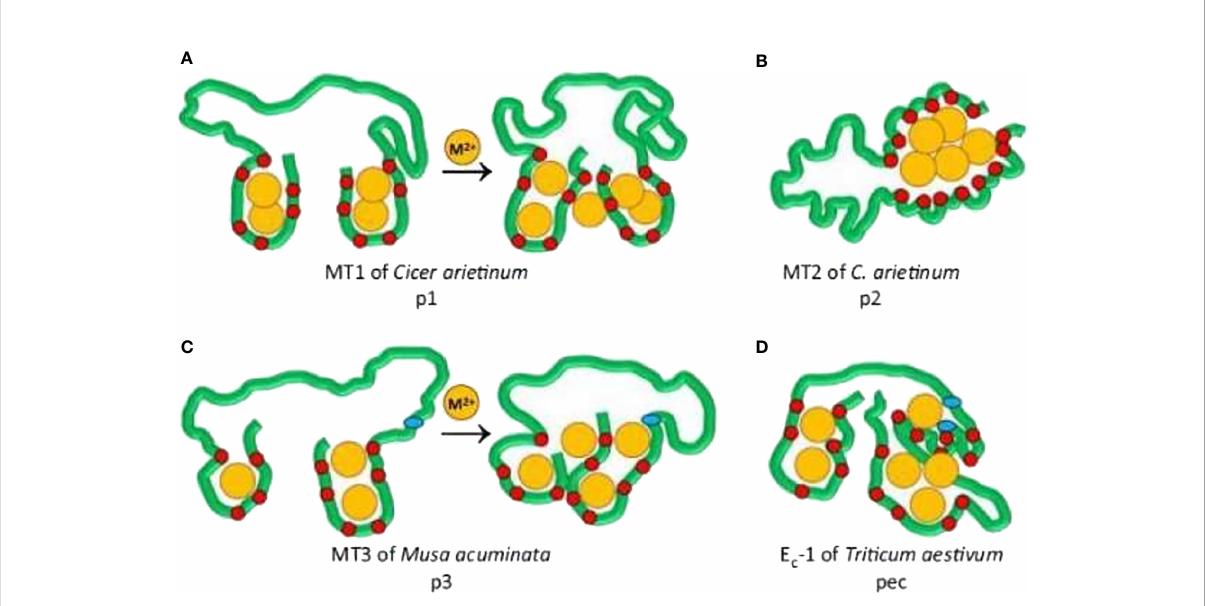
FIGURE 3 Hypothetical model of MTs in plant P1, P2, P3, and pec subfamilies: (A) MT1 in Cicer arietinum, (B) MT2 in C.arietinum; (C) MT3 in Musa acuminate; (D) Ec-1 in Triticum